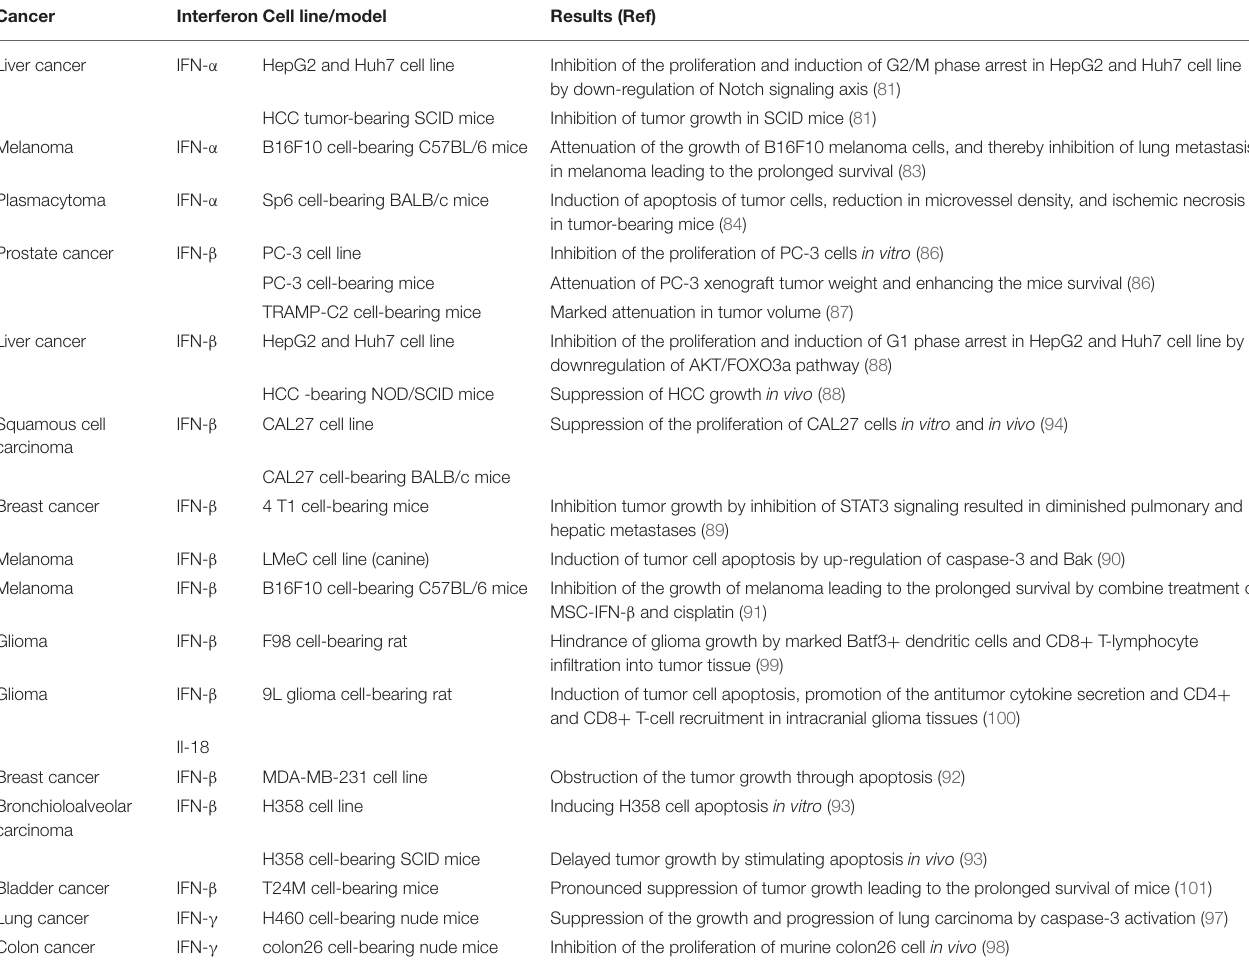
TABLE 3 | The overview of studies based on the use of mesenchymal stem/stromal cells (MSCs) as a carrier for delivery of interferons to treat human tumors ( in vitro and in vivo ).